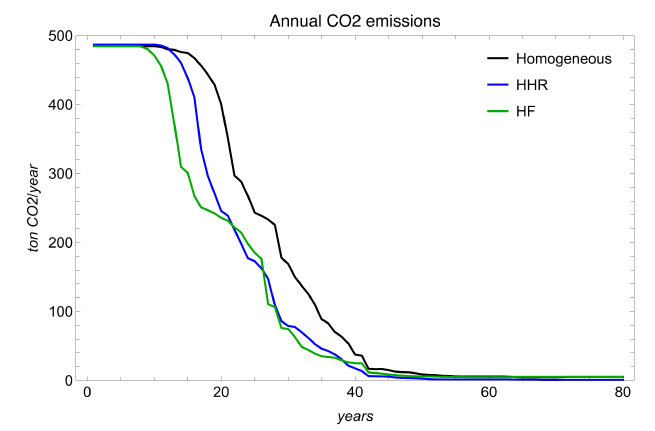
Figure 8. Annual CO 2 emissions trajectory for the homogeneous case, HHR case, and HF case.